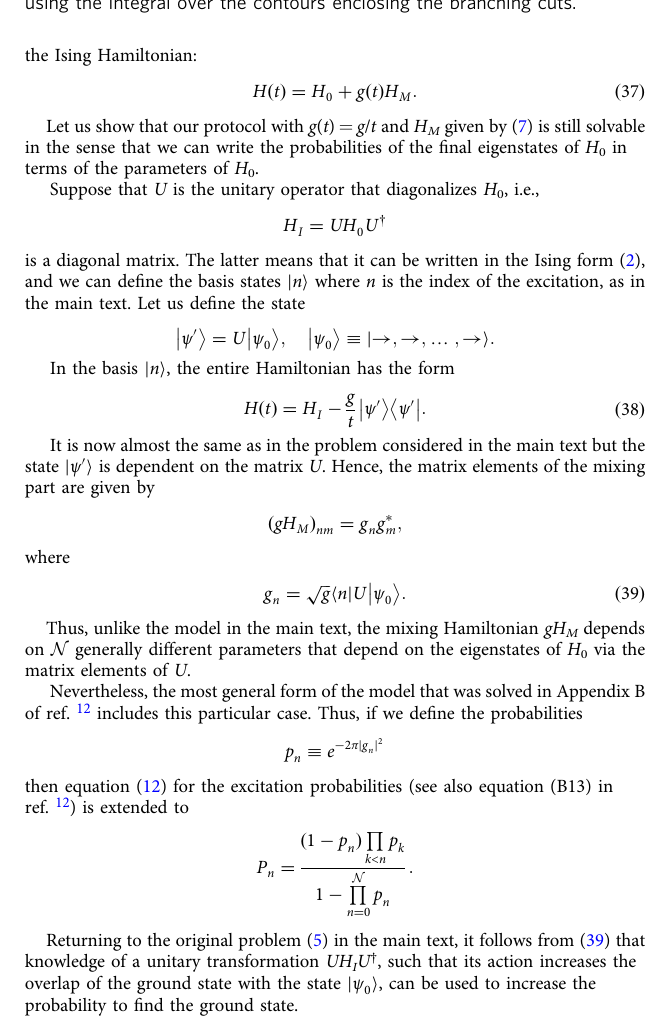
Fig. 5 Contour A de fi ned in (40). This contour integral can be computed using the integral over the contours enclosing the